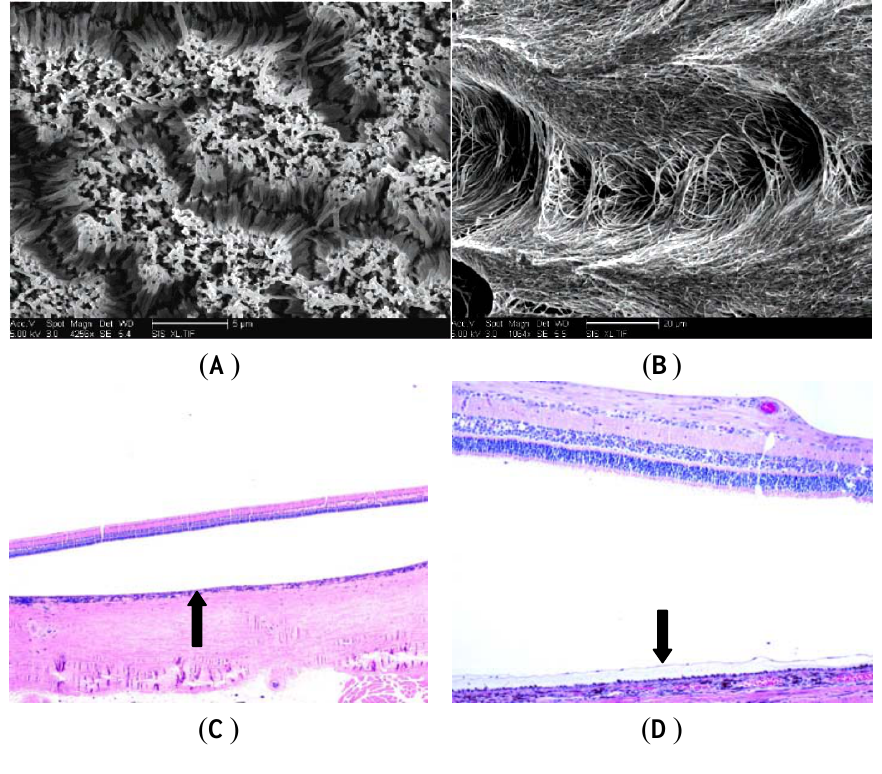
Figure 3. PCL with Incorporated Nanowire. Scanning electron micrographs show the PCL polymers with short ( A ) and long ( B ) incorporated nanowires [47]. This PCL polymer is the thinnest polymer to be used in retinal tissue engineering to date. In both the histologic images ( C , D ), the detachment of the neural retina from the RPE is an artifactual byproduct of the fixation process. The arrow on the left panel indicates the position on the polymer in the subretinal space. The inverted arrow on the right panel is demonstrating an example of a healthy retinal pigment epithelium, which further indicates the innocuous nature of the PCL